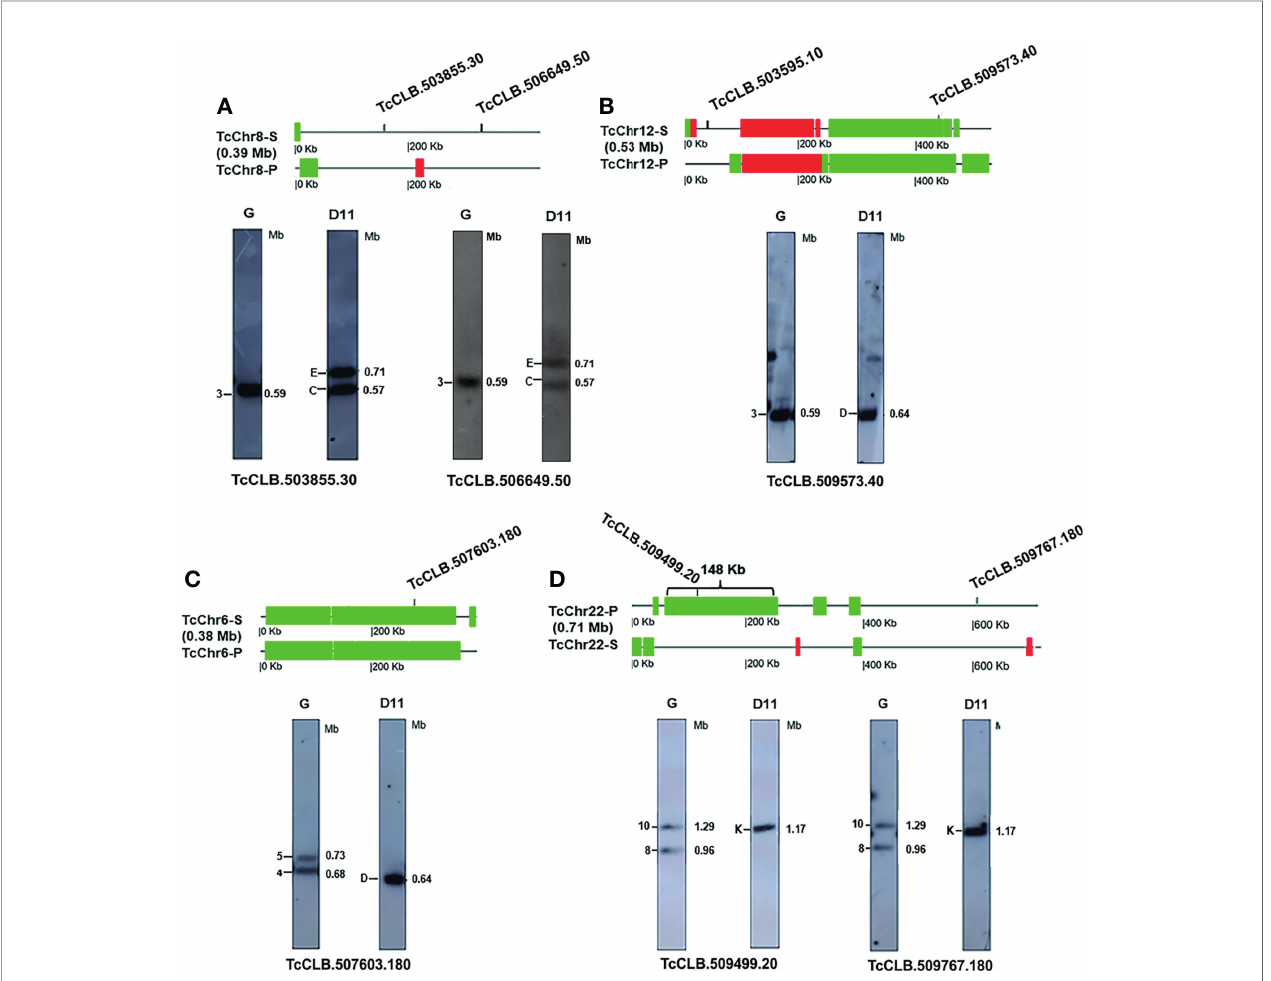
FIGURE 4 | Gross chromosomal rearrangements in clone D11 detected by aCGH and chromoblot hybridization. At the top of each panel there is a schematic representation of in silico CLB chromosomes showing the CNVs detected in clone D11 by aCGH. DNA ampli fi cation and deletion are shown in red and green, respectively. In silico chromosomes and CNVs are shown to scale. Below this is the Southern blot hybridization of chromosomal bands of the G strain and clone D11 separated by PFGE with chromosome-speci fi c markers labeled with (Zingales et al., 1997)P (see the raw image in Supplementary Figure S8 ). The number and size (Mb) of chromosomal bands are indicated. The position of the chromosome-speci fi c marker is indicated in the CLB chromosomes. The in silico chromosomes and markers are: (A) TcChr8, TcCLB.510337.30 - adenylosuccinate lyase; TcCLB.506649.50 - cytochrome c oxidase assembly factor (B) TcChr12, TcCLB.509573.40 - hypothetical protein; TcCLB.503595.10 - hypothetical protein (C) TcChr6; TcCLB.507603.180 - ubiquitin hydrolase 6 (D) TcChr22; TcCLB.509499.20 - beta propeller protein 1 BPI; T; TcCLB.509767.180 - exosome component